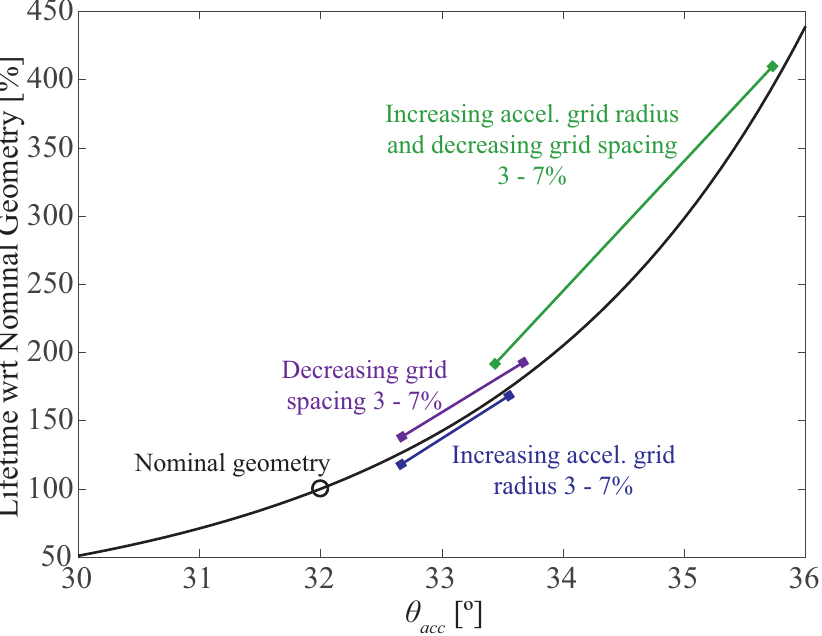
Figure 9. The effects of changing the accelerator grid’s aperture radius and the spacing between the accelerator and extractor grids on time to saturate the accelerator